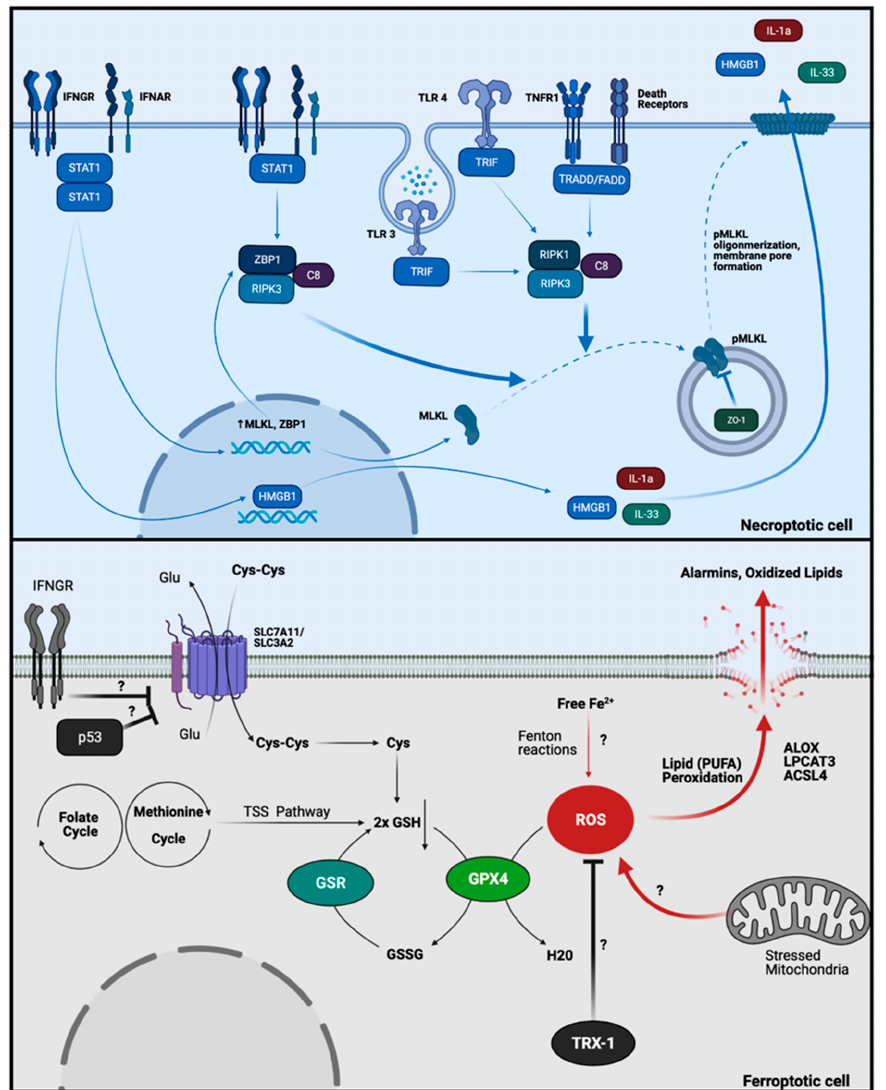
Figure 3. Other potential PCD mechanisms in CD pathology. ( Top Image ): Necroptosis. IFNs are a hallmark of CD patients, and they can stimulate the expression of necroptotic factors such as MLKL and ZBP1 and stimulate the cytoplasmic localization of HMGB1. At the same time, ZBP1 is fundamental for the direct activation of necroptosis by IFNs when caspase-8 is inhibited, by an IFNs/STAT1/ZBP1/RIPK3 mechanism. Additionally, activation of TLRs/TRIF, death receptors (TNFR1, CD95)/TRADD/FADD can induce necroptosis by activating RIPK3 in presence of caspase-8 inhibition. RIPK3 activation leads to MLKL phosphorylation (pMLKL) and migration to the cell membrane in vesicle co-transported with a regulatory factor, ZO-1. As ZO-1 is downregulated in epithelial cells of untreated CD patients, it may indicate a pro-necroptotic phenotype of this cell type. When pMLKL monomers are oligomerized in the plasma membrane, this creates a pore, which leads to necroptosis cell death and the alarmins (IL-1 α , IL-33, HMGB1) release. ( Bottom Image ): Ferroptosis. CD patients show a dramatic increase in ROS production and oxidative stress markers which could be related to a new form of inflammatory PCD called ferroptosis. This PCD could be triggered by inhibiting GPX4 through a reduction of GSH. Both facts have been found in untreated CD patients’ cells. Additionally, IFN γ and p53, both factors related to CD pathology, can reduce the transport of cystine (Cys-Cys) a critical precursor of GSH biosynthesis by inhibiting its membrane transporter (SLC3A2 and SLC7A11). Moreover, the GPX4 downregulation could be a response to the ROS increase if other reductive systems failed (i.e., TRX1). The massive increase in ROS could be triggered by stressed organelles such as mitochondria and the free iron pool. Ultimately, the reduced activity of GPX4 leads to ALOXs, LPCAT3, and ACSL4 increase in membrane PUFA peroxidation and cell death, with the release of alarmins and inflammatory oxidized